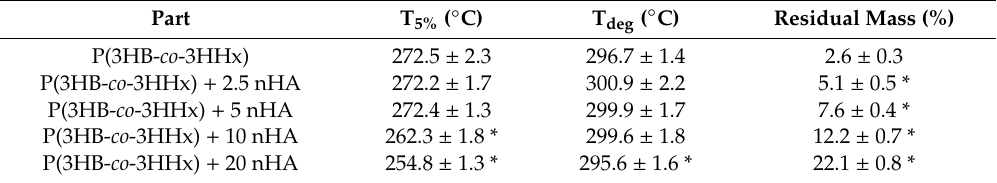
Table 6. Main thermal degradation parameters of the injection-molded poly(3-hydroxybutyrate- co -3-hydroxyhexanoate) [P(3HB- co -3HHx)] / hydroxyapatite nanoparticle (nHA) parts in terms of onset temperature of degradation (T 5% ), degradation temperature (T deg ), and residual mass at 700 ◦